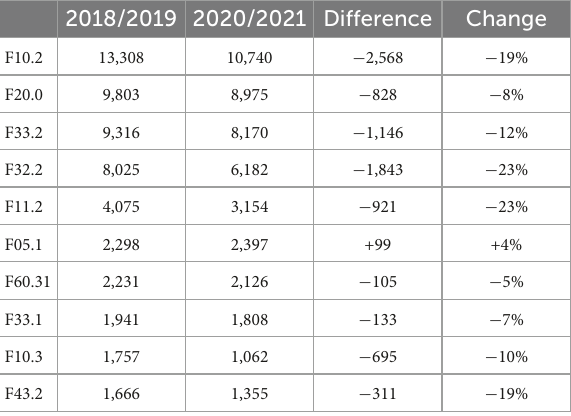
TABLE 1 Change in the frequency of the 10 most frequent admission diagnoses of the 2018/2019 period.